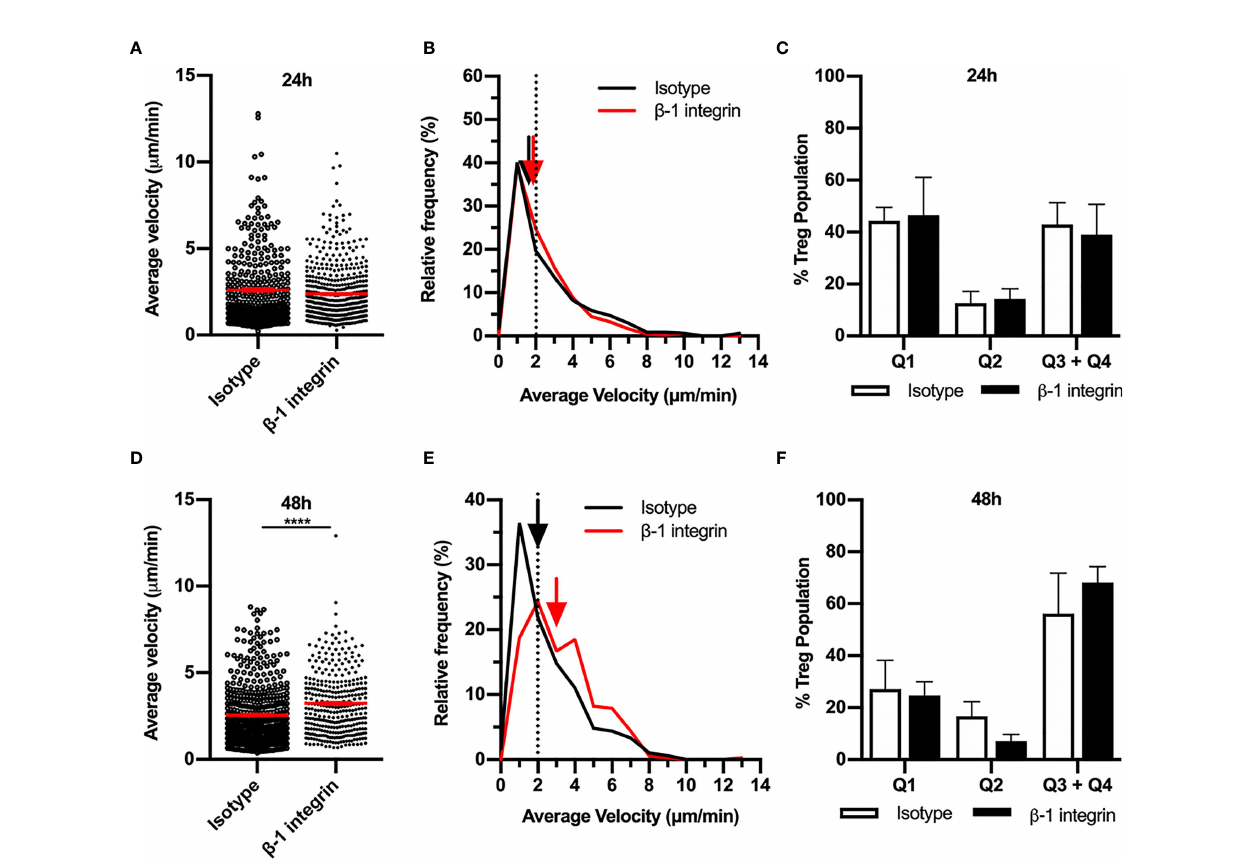
FIGURE 5 | b 1 integrin modulates Treg migration speed during 48 h CS-induced in fl ammation. The contribution of the b 1 integrin to Treg migration in CS-in fl amed skin was assessed using MP-IVM of CS-in fl amed skin following the i.d. injection of anti- b 1 integrin or isotype control antibodies 2 h prior to visualization by MP-IVM. Effect of anti- b 1 integrin treatment on Treg migration velocity 24 h (A – C) or 48 h (D – F) after induction of CS. (A, D) Treg migration velocity 24 (A) and 48 h (D) post CS induction. Data show velocities for individual Tregs as well as group mean ± sem. (B, E) Relative frequency distributions of the average velocities of individual Tregs from 24 h (B) or 48 h (E) after CS induction. Arrows indicate the median velocity and dotted line indicates the 2 µm/min threshold of motility. (C, F) Distributions of Tregs within the four quadrants of the velocity vs . con fi nement plots shown for 24 h (C) and 48 h (F) post induction of CS, in anti- b 1 integrin vs . isotype control mice. Data represent the mean ± SEM of > 350 cells derived from 3-5 mice/group. Quadrant data represent mean ± SEM of data averaged from 3 fov/mouse. Data in (A, D) analysed using Mann-Whitney test. **** p <